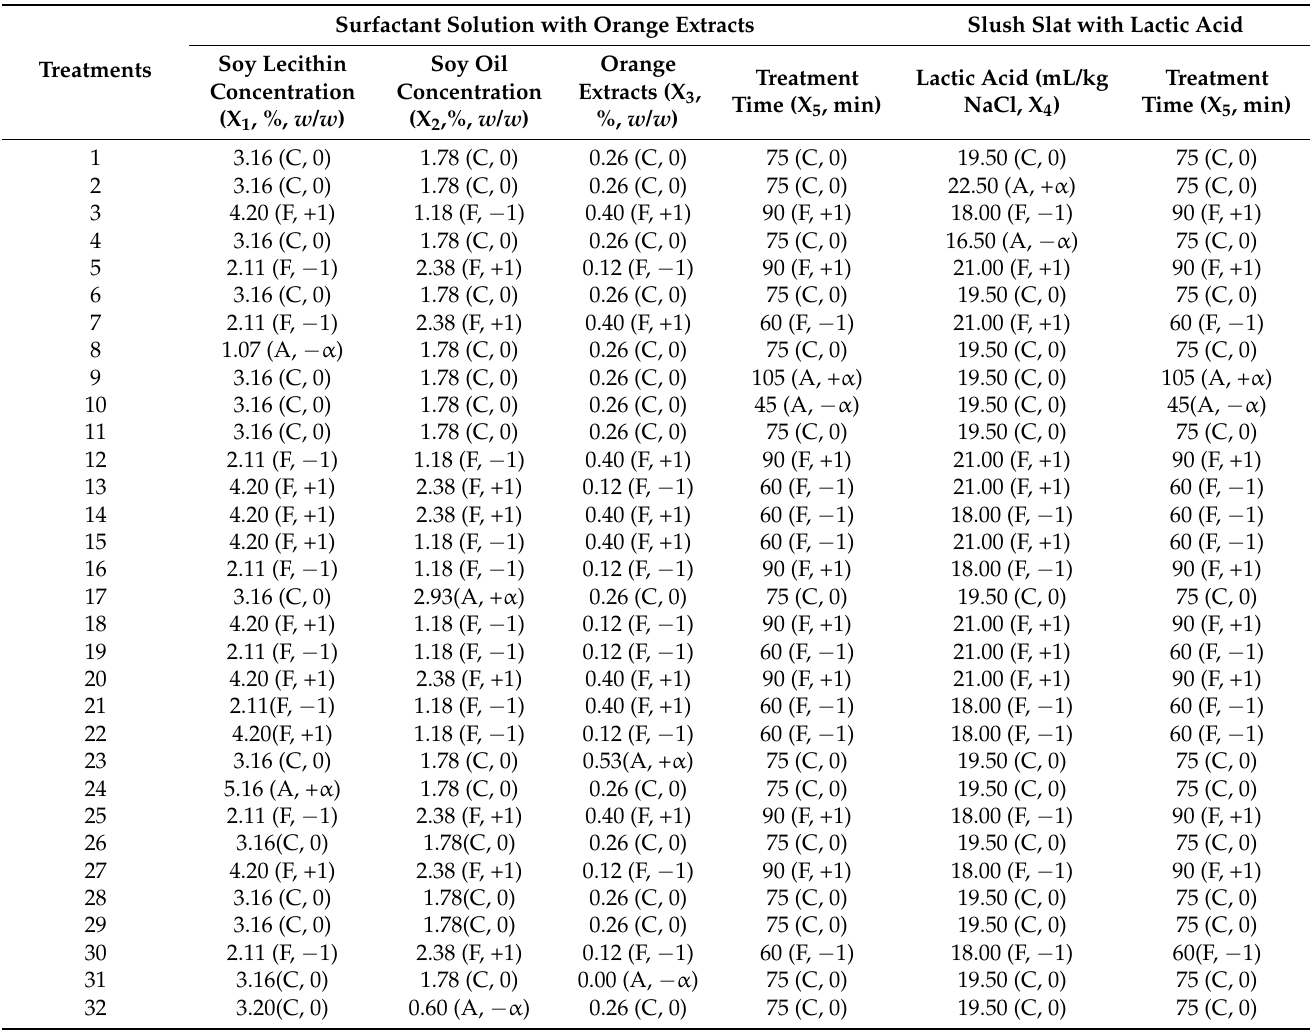
Table 1. Casing modification treatment